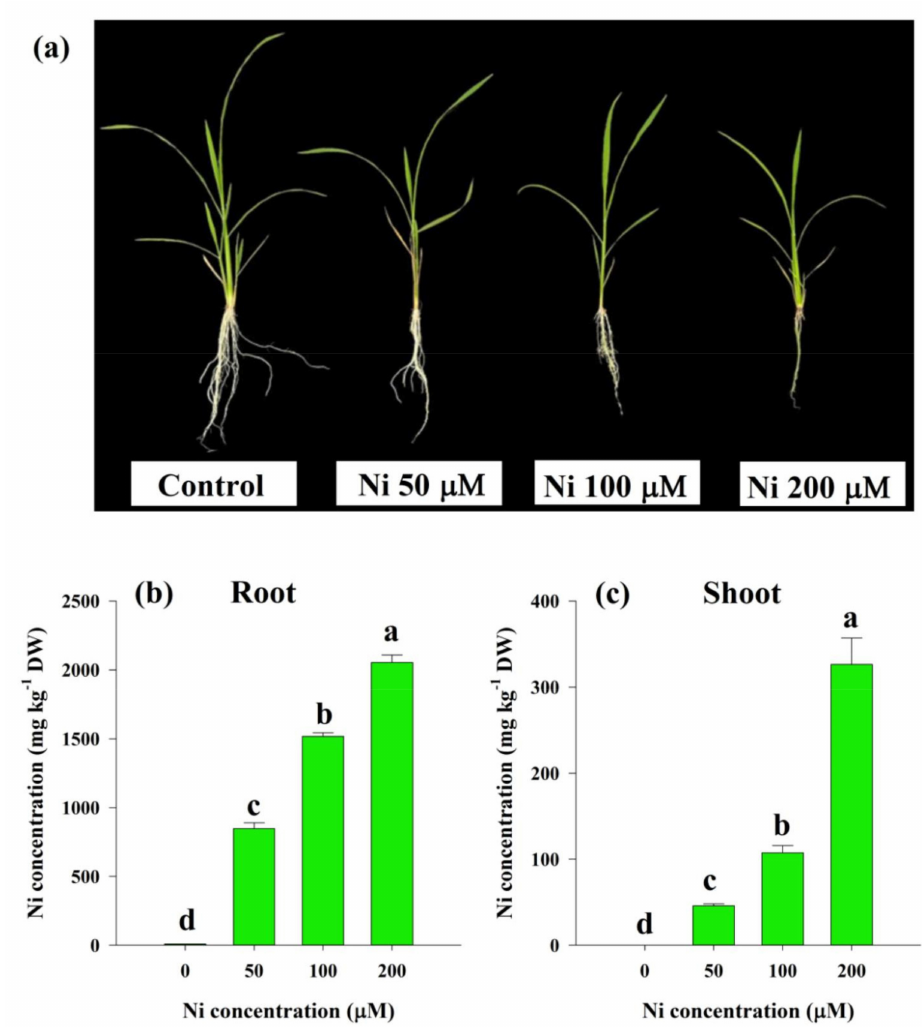
Figure 1. Symptoms of nickel (Ni) toxicity ( a ), Ni concentrations in the root ( b ), and shoot ( c ) of rice seedlings subjected to 0, 50, 100 and 200 µ M Ni for a period of 14 days. Bars represent means ± standard deviations (SDs) of three independent replications ( n = 3). Means followed by the same letter did not significantly differ among the treatments at p < 0.05, according to Fisher’s least significant difference